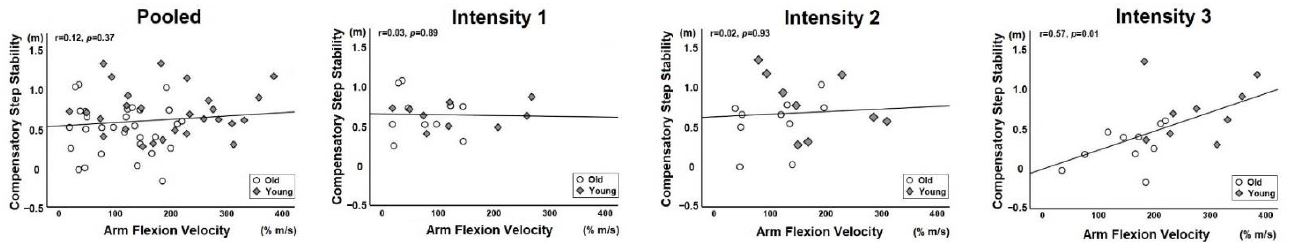
Figure 5. Correlation between maximal arm elevation velocity and first compensatory step stability at TD at each perturbation intensity. Pooled: combined set of all three perturbation intensities. There was a positive correlation at intensity 3.